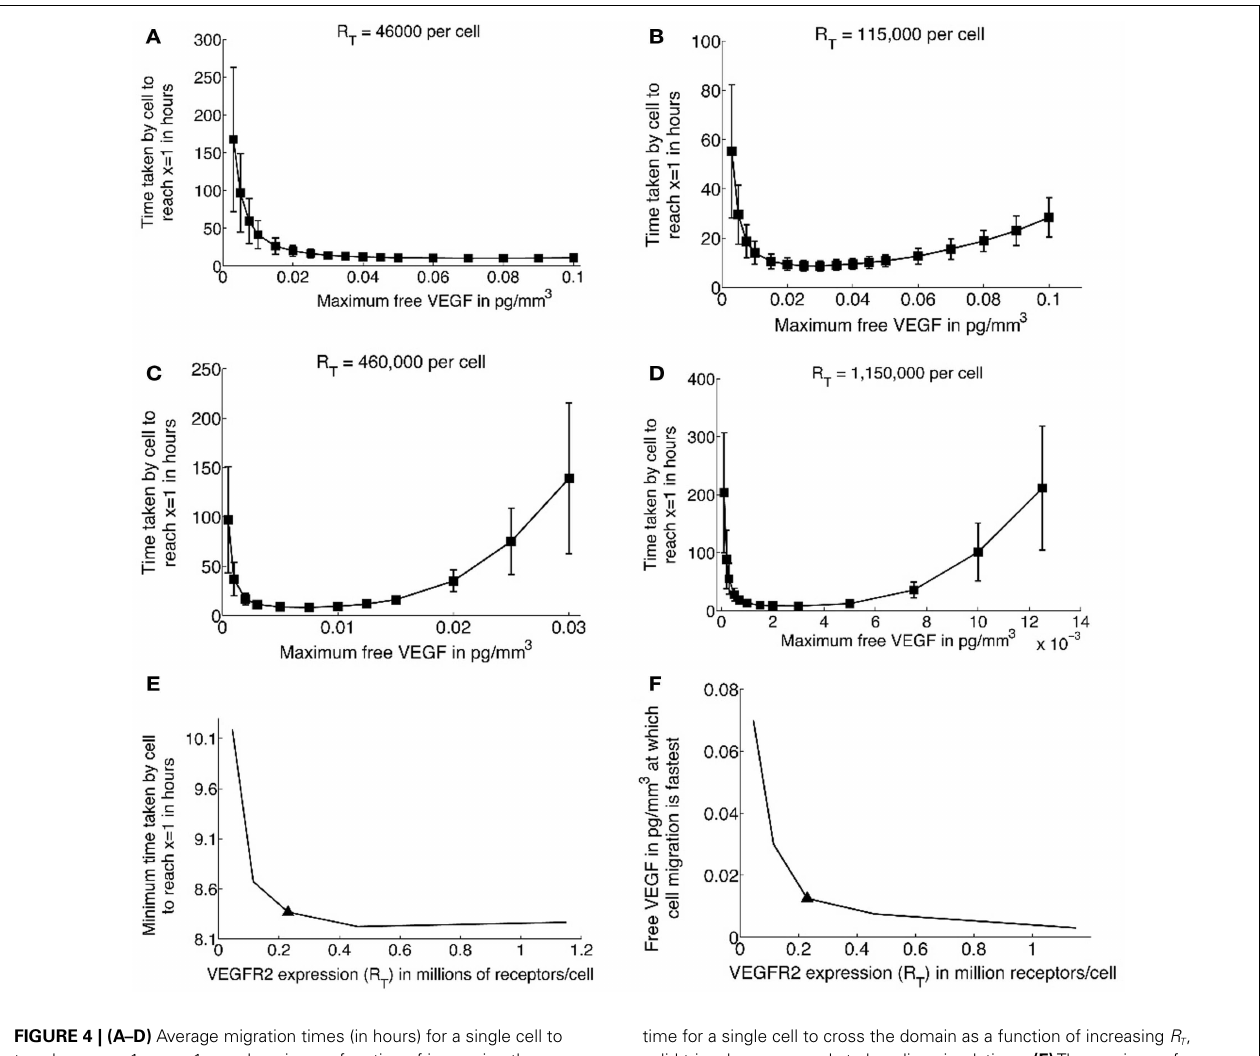
FIGURE 4 | (A–D) Average migration times (in hours) for a single cell to travel across a 1mm × 1mm domain as a function of increasing the maximum freeVEGF concentration at a lattice site, for different values of R T , the total number ofVEGFR2 per cell. Baseline simulations correspond to R T = 230,000/cell, and are shown in Figure 2C . (E) Minimum migration